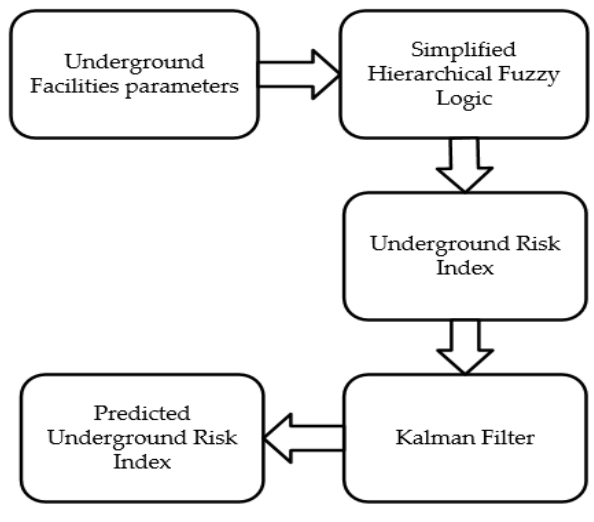
Figure 1. Proposed conceptual model.